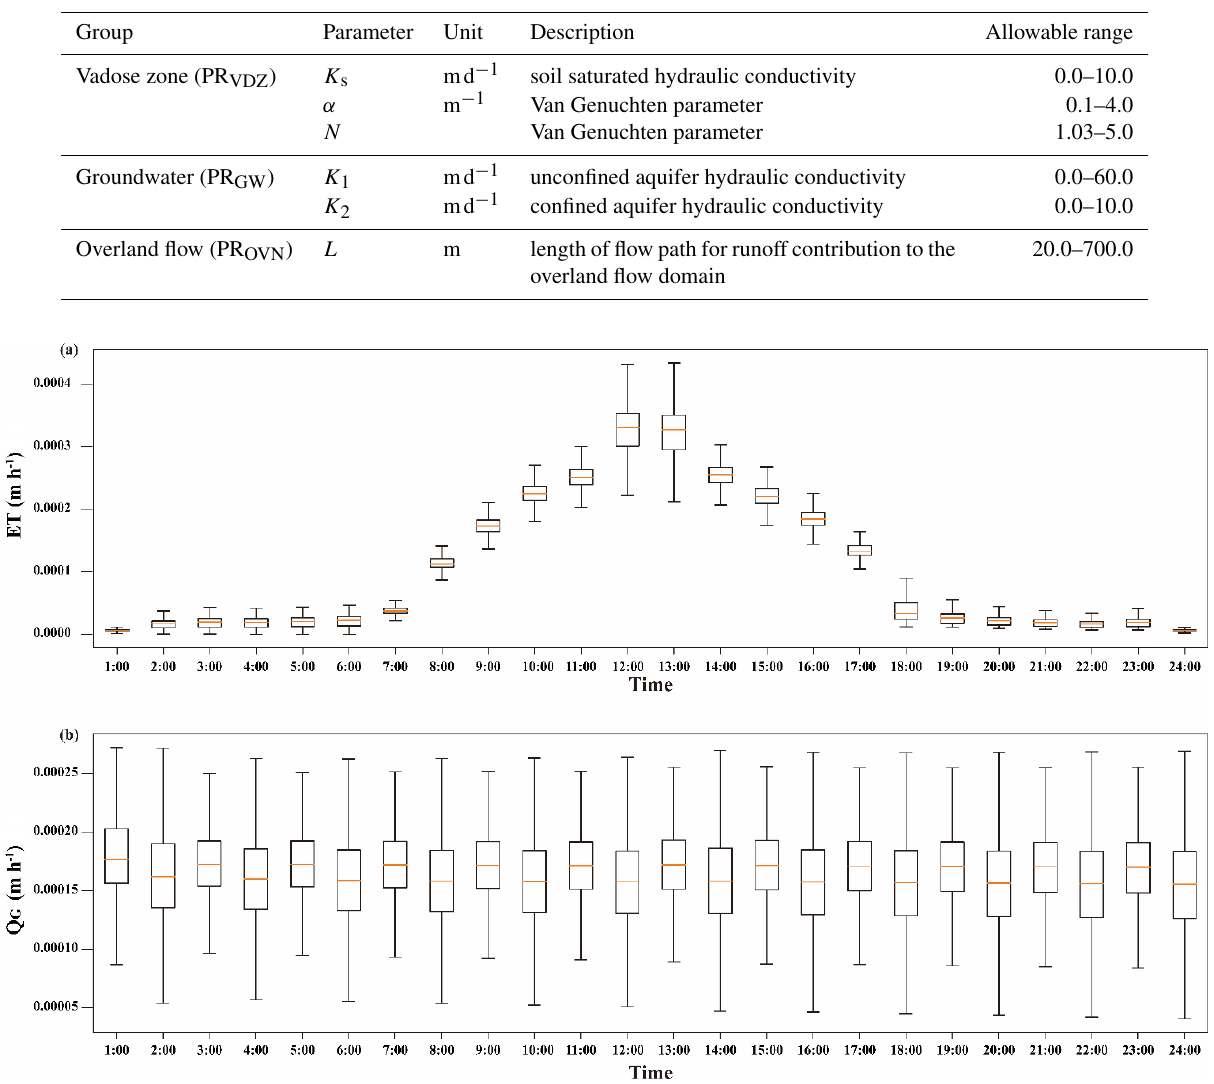
Figure 4. The spatial-accumulative outputs for evapotranspiration (ET) (a) and groundwater contribution to stream flow ( Q G ) (b) at all time steps and considering all three uncertainties. Each time step is divided into different groups based on local time. Different groups represent different hours of the